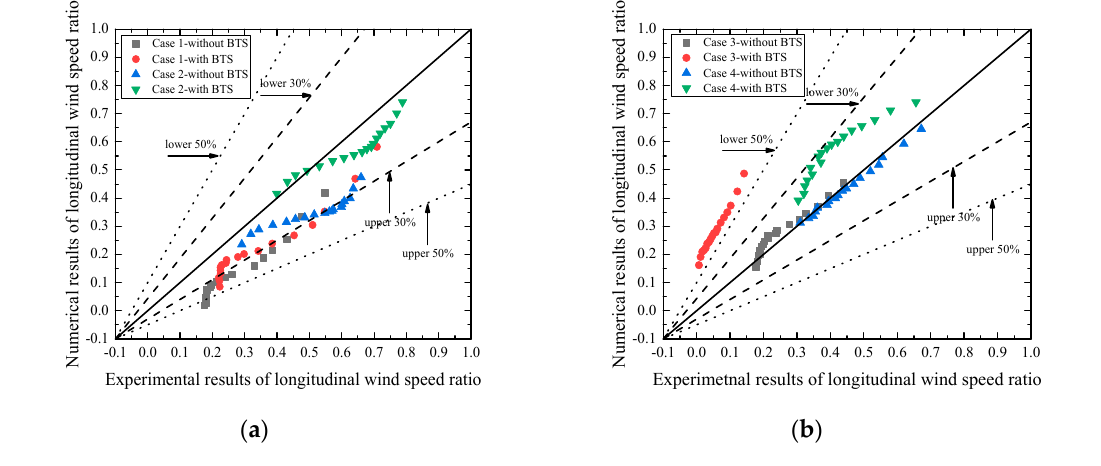
Figure 21. Numerical results vs. experimental results of longitudinal wind speed ratio at L/2 under different cases. ( a ) Case 1 and 2; ( b ) Case 3 and 4.